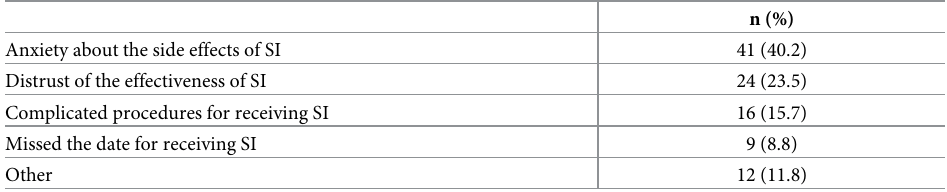
Table 2. Reasons for not having received PDSI.